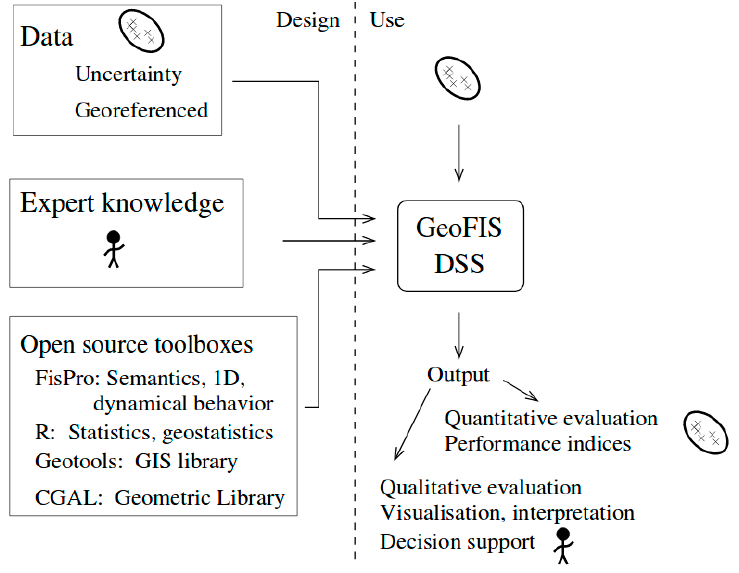
Figure 1. The GeoFIS architecture [30]. CGAL, Computational Geometry Algorithms Library; DSS, Decision Support Systems; GIS, Geographic Information System; 1D, One dimension.